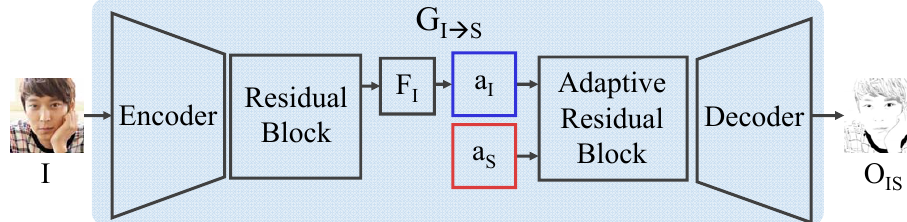
Figure 4. The structure of our generator.